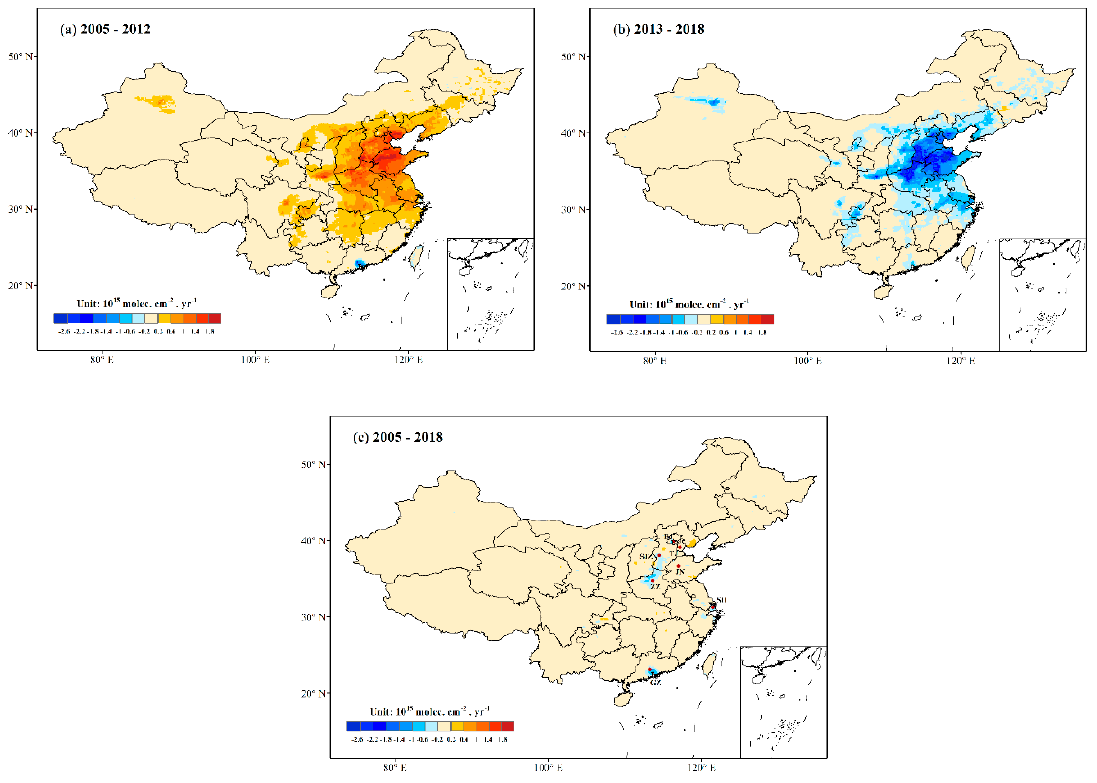
Figure 2. Tropospheric NO 2 VCD linear trends over China (unit: 10 15 molec cm − 2 year − 1 ): ( a ) from 2005–2012; ( b ) from 2013–2018; and ( c ) from 2005–2018. The red dots denote the seven cities we discussed in Section 3.2. From north to south, these cities are Beijing, Tianjin, Shijiazhuang, Jinan, Zhengzhou, Shanghai and Guangzhou.).